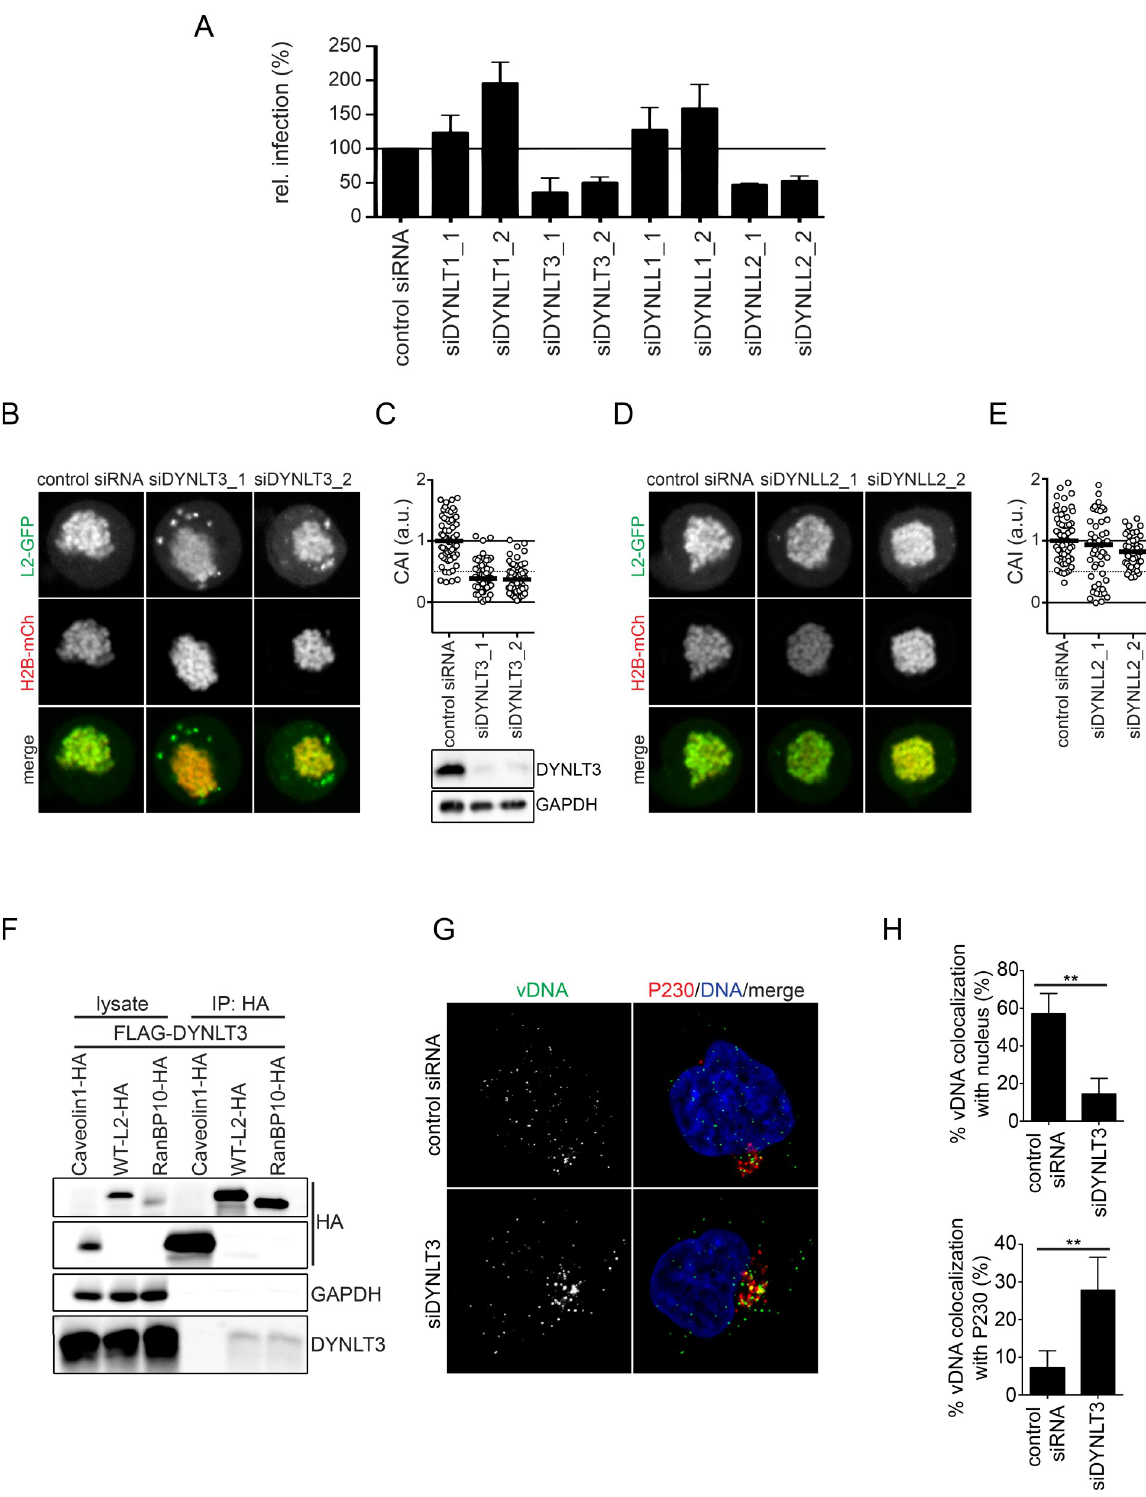
Fig 7. Dynein light chain DYNLT3 facilitates nuclear delivery of incoming HPV16. (A) RNAi of various dynein light chains by each two individual siRNAs as indicated in HeLa cells was followed by HPV16-PsV infection. Infectivity was scored based on cells expressing GFP over total cells. The infectivity was normalized to control siRNA transfected cells as relative (rel.) infection. Error bars indicate the SD of three independent experiments. (B)(D) A L2 chromosomal association assay after DYNLT3 (B) or DYNLL2 (D) depletion in HeLa Kyoto_H2B-